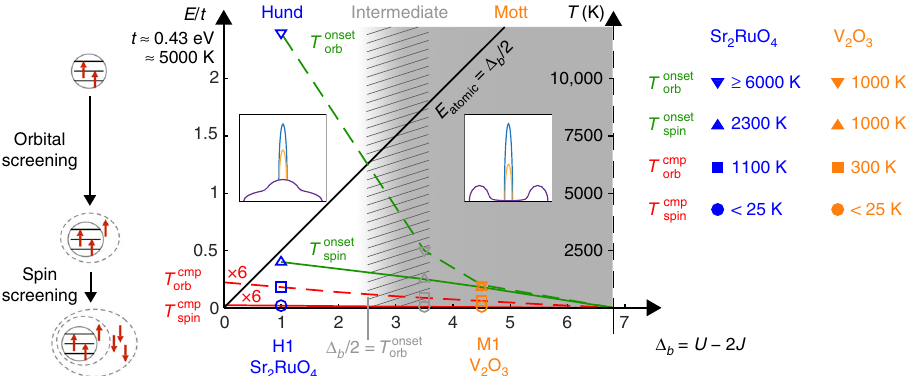
(green dashed), T onset (green solid), T cmp (red dashed), T cmp Fig. 1 Schematic sketch of the behavior of four characteristic temperature scales. T onset spin spin orb orb (red solid) mark the onset and the completion of screening of orbital and spin degrees of freedom, respectively, as functions of the bare gap, Δ b = U − 2 J , between the upper and lower Hubbard side band. White (gray) background indicates Hund (Mott) behavior at small (large) Δ b . A crossover between both (oblique gray lines) is found at intermediate Δ b . Open symbols on the left give the values of these scales as obtained from DMFT + NRG calculations for our three-band Hubbard – Hund model, with J = 1 and U = 3 (green), U = 5.5 (gray), and U = 6.5 (yellow). On the right, closed symbols give corresponding values obtained from DFT + DMFT calculations for the materials Sr 2 RuO 4 (green) and V 2 O 3 (yellow). Left: cartoon of two-stage screening for three local levels with J ≠ 0, containing two electrons with total spin S = 1: with decreasing temperature, fi rst orbital screening of the hole occurs, whereby a delocalized spin 1/2 combines with the local spin 1 to yield an orbital singlet with spin 3/2; then spin screening occurs, yielding an orbital and spin singlet 10 . The energy scales characterizing the two screening stages lie far apart for Hund systems, but close together for Mott systems. Insets: cartoons of the local density of states, A ( ω ), for a Hund system (left) and a Mott system close to the Mott transition (right), summarizing the essential differences in the evolution of the quasiparticle peak with decreasing temperature (purple to yellow to